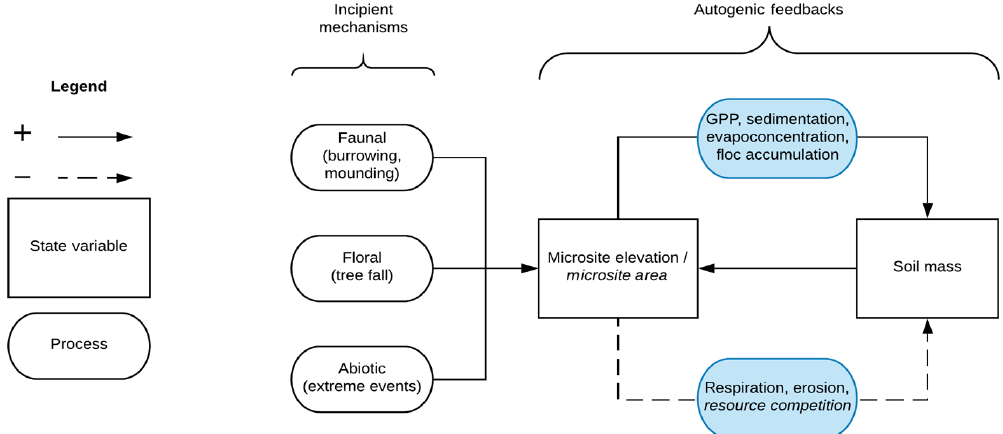
Figure 1. Conceptual model for autogenic hummock maintenance in wetlands. Incipient mechanisms create small-scale variation in soil elevation that is amplified by autogenic feedbacks, which grow and maintain elevated hummock structures. Solid lines indicate positive feedback loops, and dashed lines indicate negative feedback loops. Font in italics refer to feedback processes hypothesized to only affect the lateral hummock extent (thus the hummock area), whereas standard font indicates mechanisms that affect both the vertical and lateral hummock extent. Processes in blue indicate that these mechanisms are influenced by hydrology. Soil mass refers to the amount of (organic) soil in a hummock, which can include roots, leaves, and decaying organic matter.